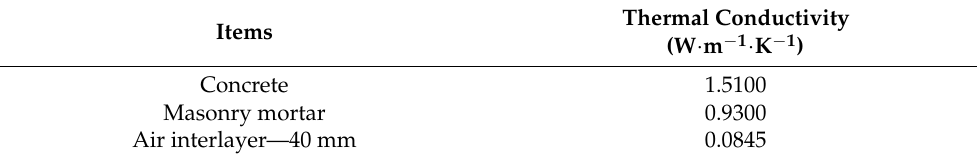
Table 2. Thermal conductivity values.